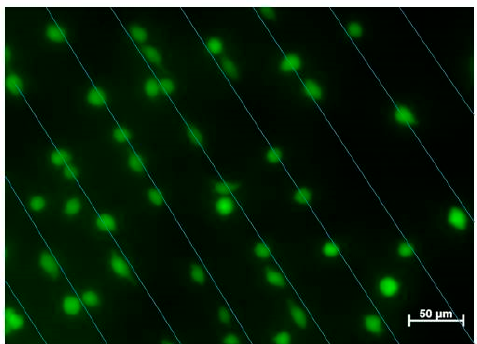
Figure 11 . Fluorescent images of L-929 cells after being cultured on the surface of 8PEG-VS-SH hydrogel with patterned Au NPs (d = 42 nm) stripes (50 μ m in distance of the inter-stripes) for 24 h. Straight lines were drawn to represent the patterned Au NPs below the cells.